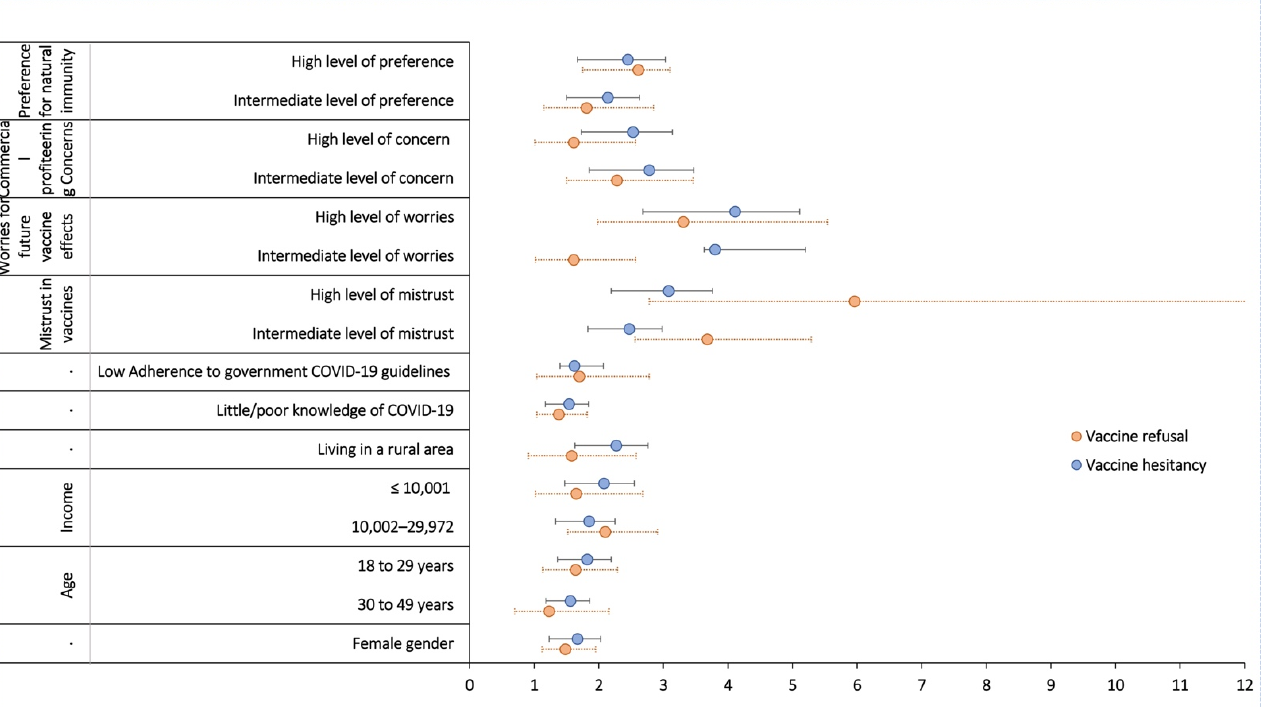
Figure 3. Predictors of COVID-19 vaccine refusal and hesitancy. Predictors of COVID-19 vaccine refusal and hesitancy using multivariable logistic regression analysis.